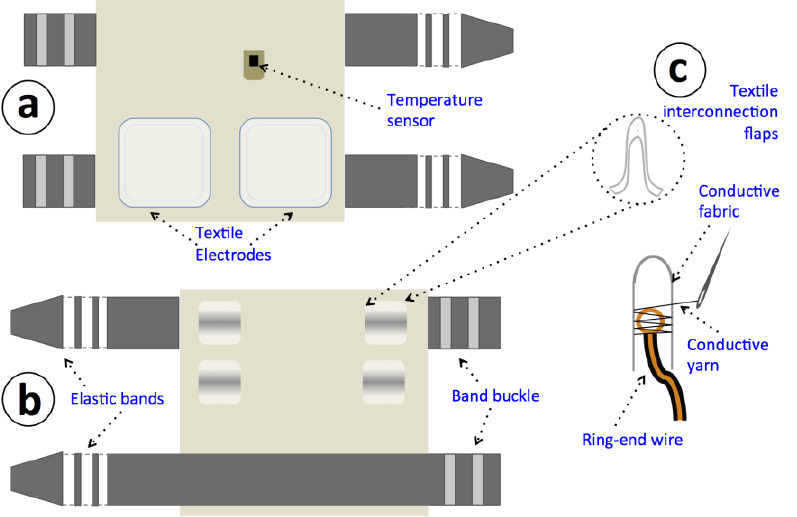
Figure 6. Drawing of the confectioned sensorized upper arm strap. ( a ) Inside view, showing the sensors. ( b ) Outside side, where the sensing device is placed and connected. ( c ) Detail of the textile-electronic interconnection achieved by using conductive fabrics, yarn and sewing them through a ring-shaped end.